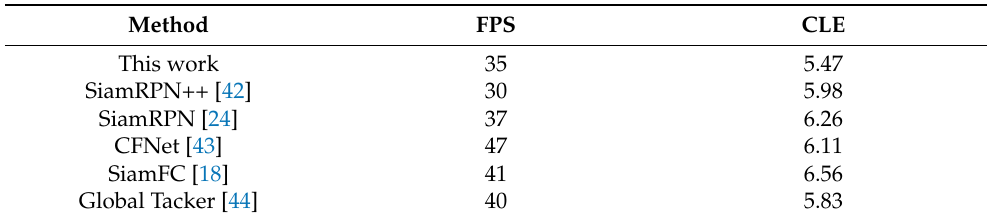
Table 1. The FPS and CLE of different localization frameworks.